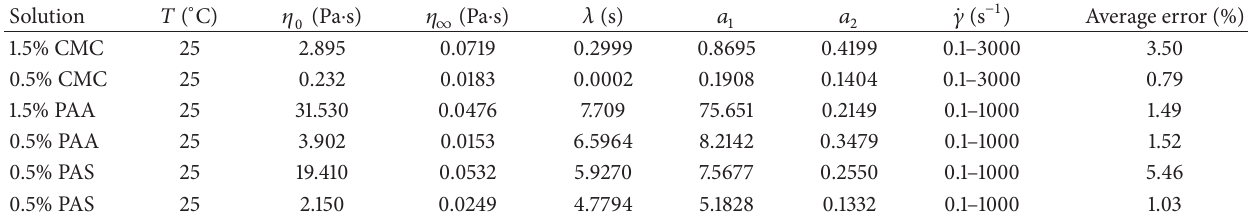
Table 1: Parameters of the Carreau-Yasuda viscosity model for the studied solutions.